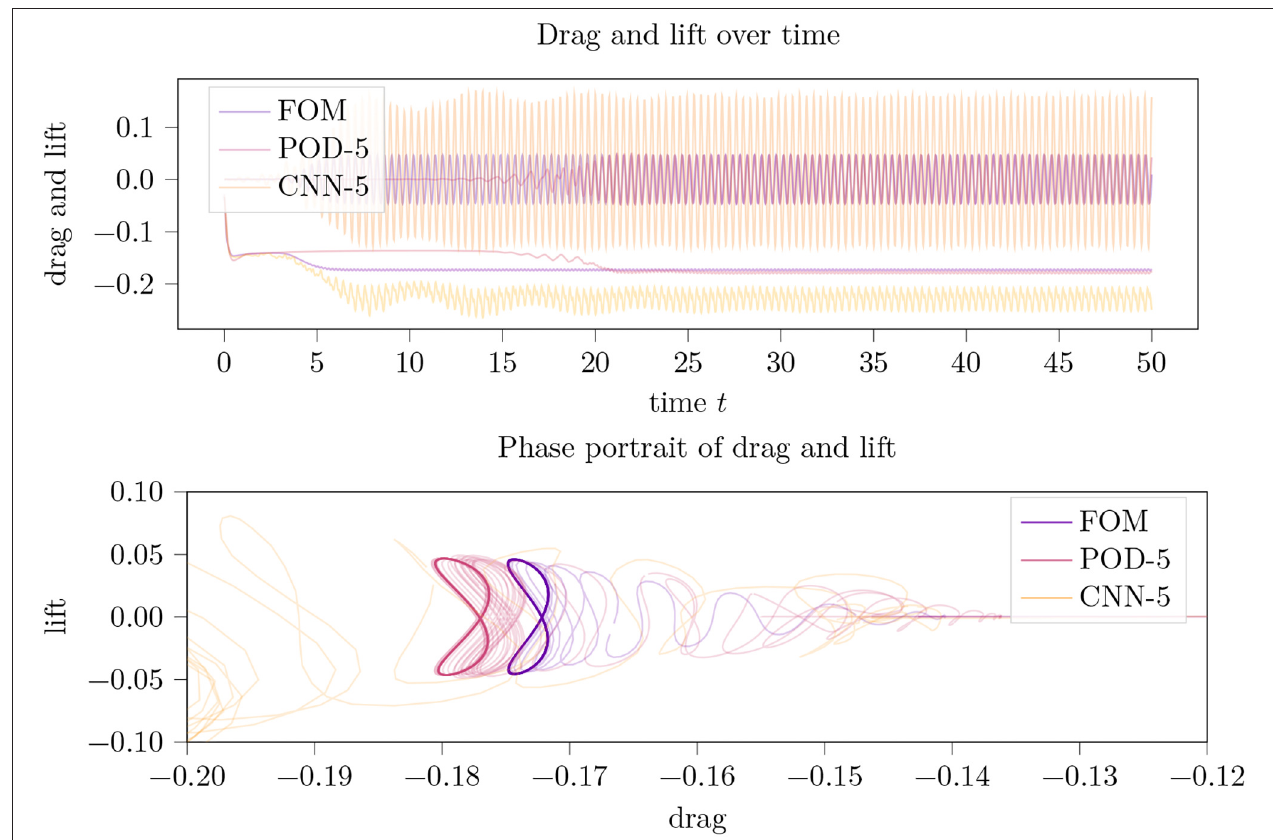
FIGURE 5 | Drag and lift trajectories (top) over time and their phase portrait (bottom picture) for an LPV approximation of the incompressible flow around a 2D cylinder using a parameter dimension of cs = 5 . In the phase portrait plot, parts of CAE -5 were